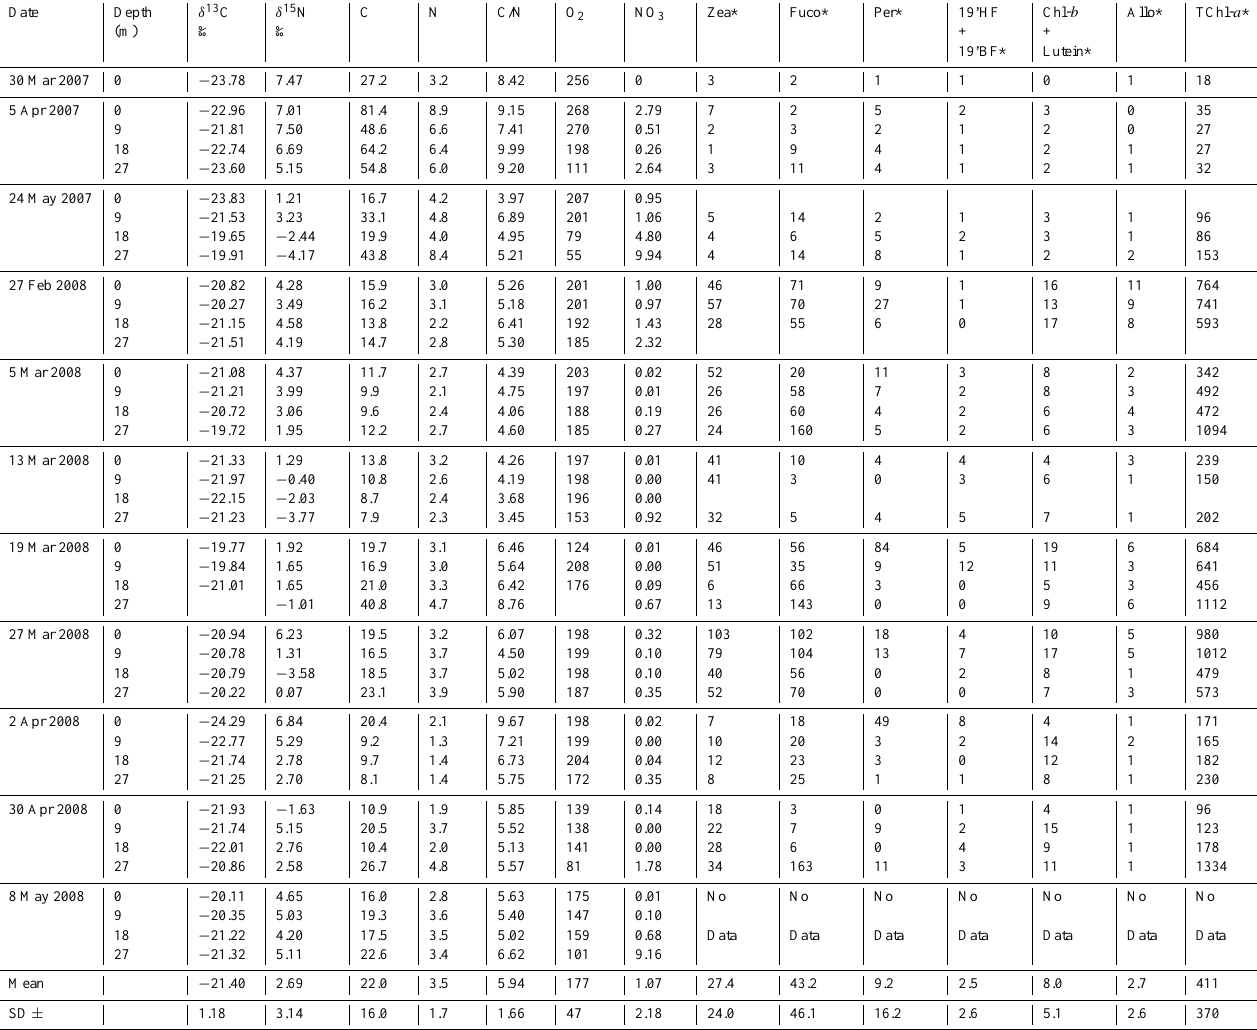
Table 1. Isotopic values ( δ 13 C and δ 15 N) of SPOM, their elemental C and N concentrations (µM), C/N ratios, O 2 , NO − pigment abundance (ngl − 1 ) during pre-monsoon season at G5 station in the